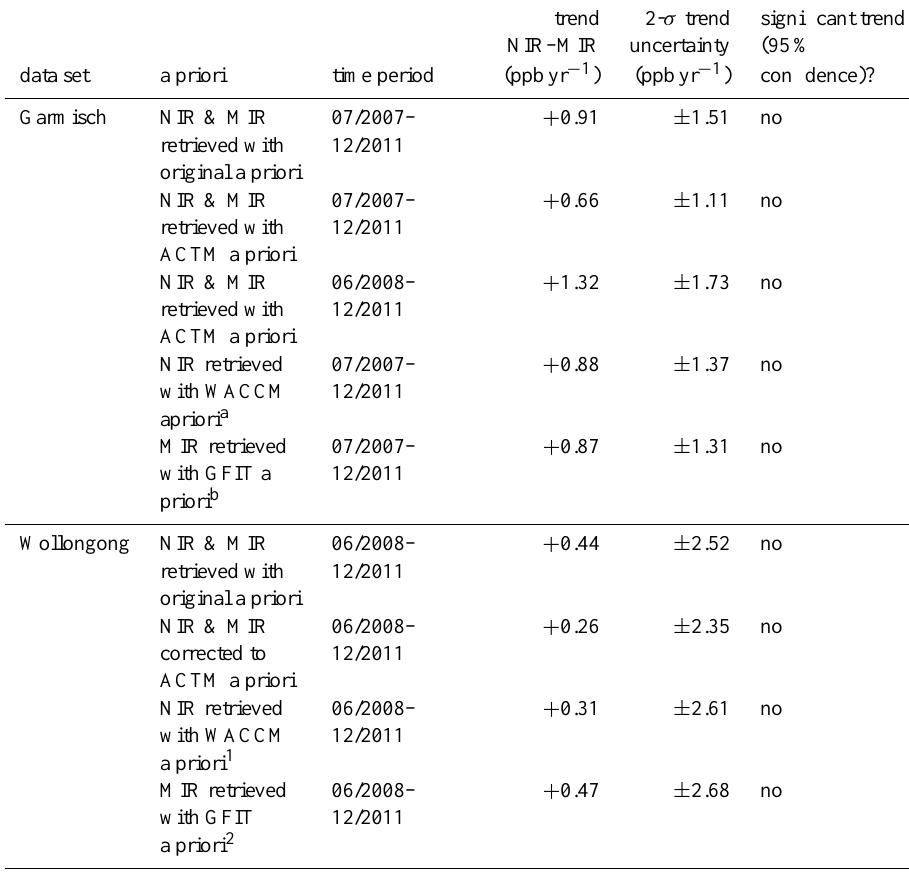
Table 3. Trend analysis of the XCH 4 difference time series